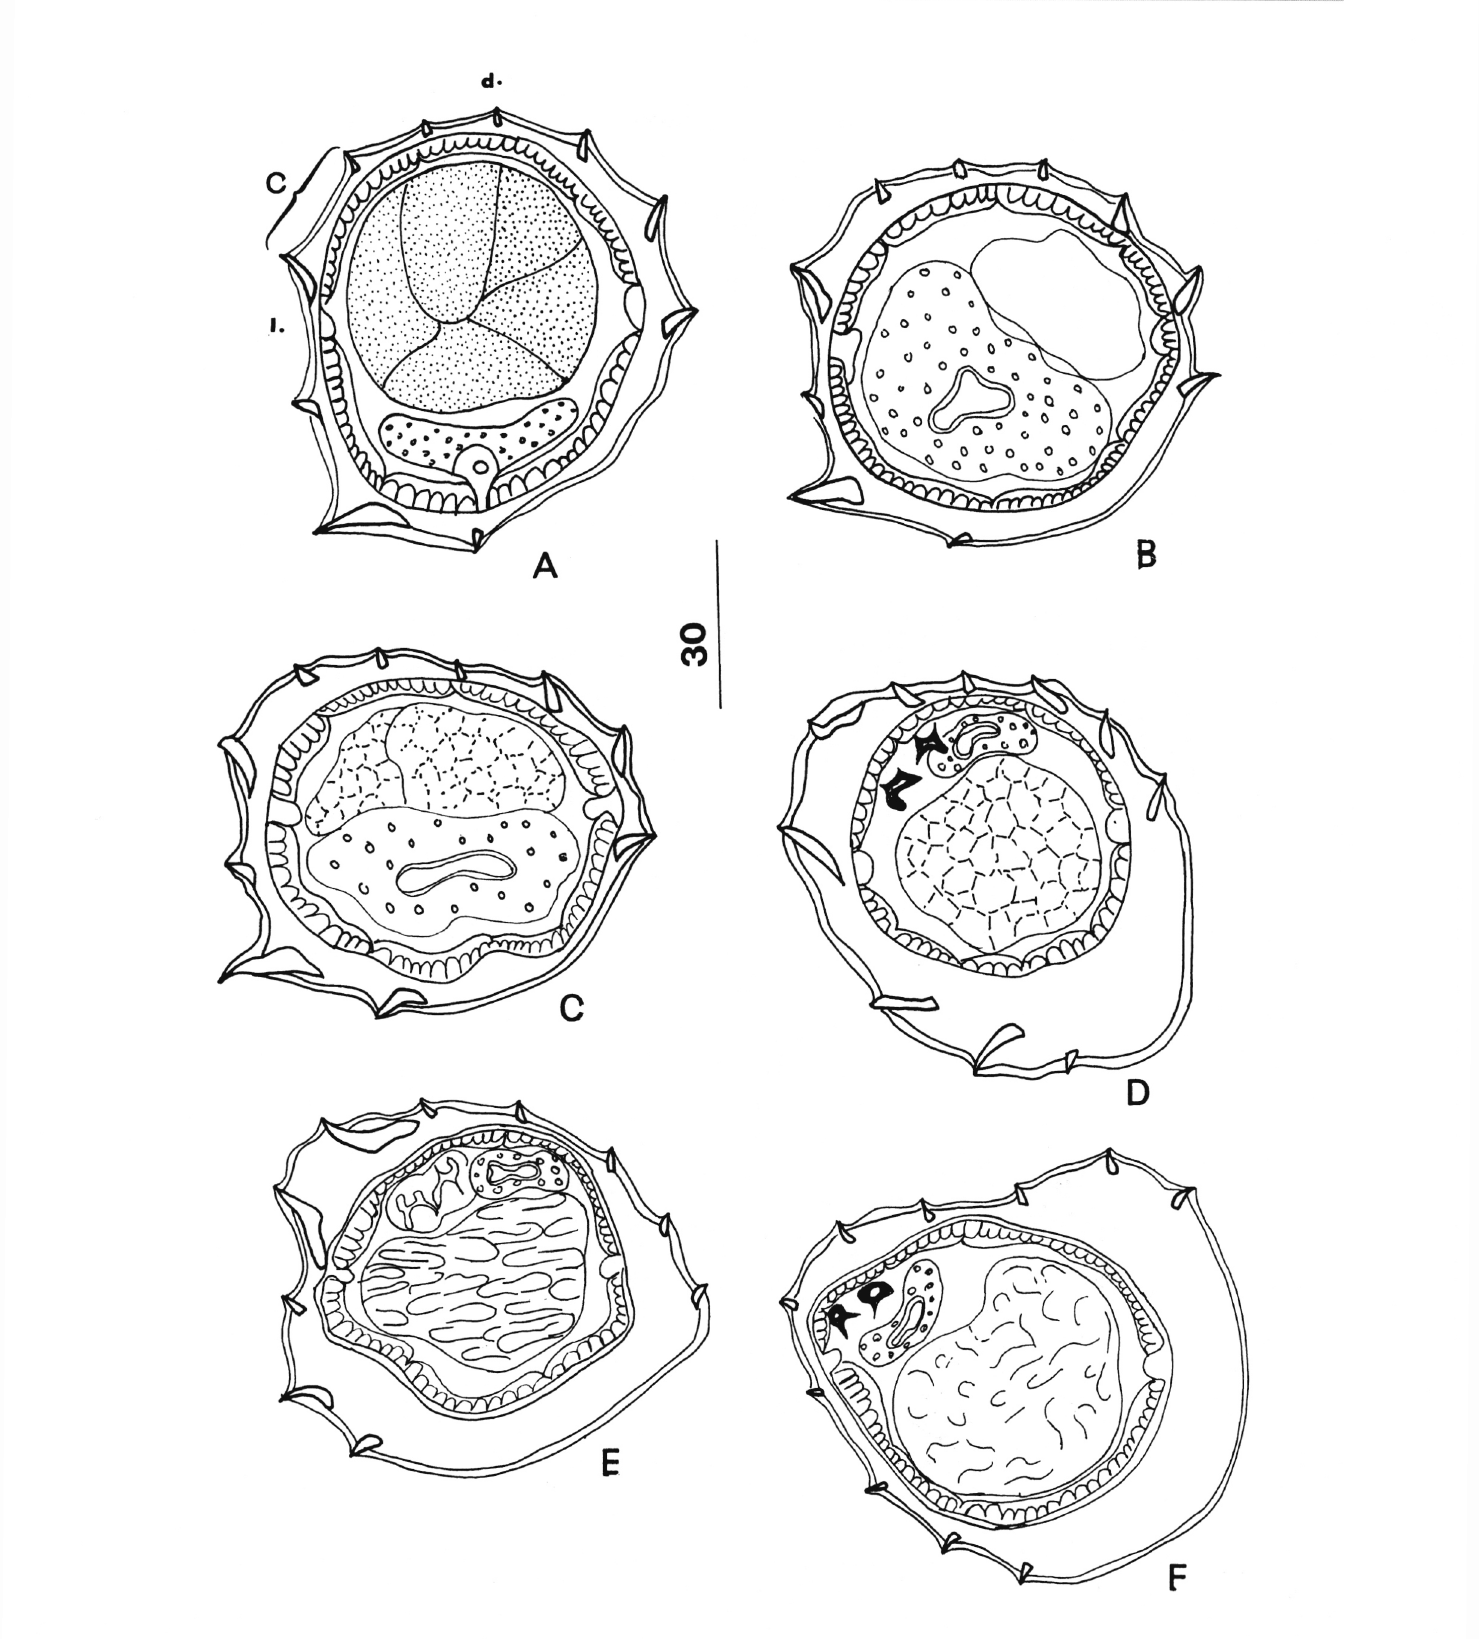
Fig. 1. - Pudica ginsburgi n. sp. Male from voucher material, 2.65 mm long, transverse sections of the body. A, at level of the excretory pore. B, at the beginning of the oesophagus. C, at 770 pm from head. D, at mid-body. E, at 940 μ m from the caudal bursa. F, at 880 pm from the caudal bursa. All the sections are orientated as A. Abbreviations: c: carene, 1: left side, d: dorsal side. Parasite, 2001, 8, 223-230 Mémoire